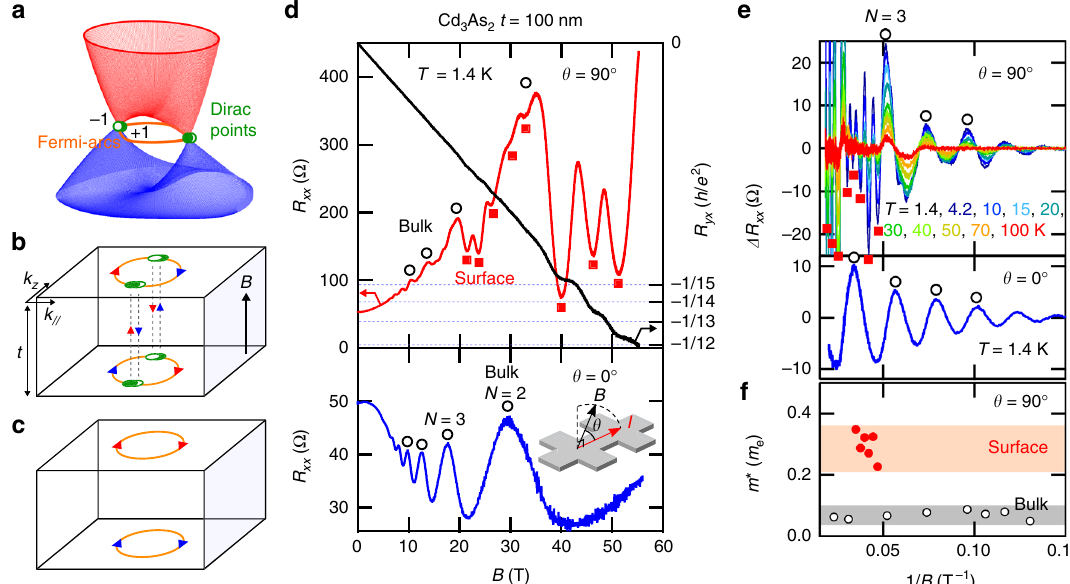
Fig. 1 Surface quantum transport in a Cd 3 As 2 thin fi lm. a Low-energy band dispersion of a Dirac semimetal (DSM). DSM consists of two copies of a Weyl semimetal superimposed with opposite chirality ±1. b , c Magnetic orbits mediated by the surface states in a DSM slab with thickness t . The two Fermi-arcs on the top and bottom surfaces are interconnected through the bulk chiral zero mode in b , while the two Fermi-arcs on the same surface deform into a closed Fermi pocket to form a conventional orbit localized at each surface in c . d Out-of-plane transverse (upper panel) and longitudinal (lower panel) magnetoresistances (MRs) of a 100 nm thick Cd 3 As 2 fi lm. The right axis of the upper panel shows Hall resistance R yx . θ indicates an angle between the fi eld B and current I . Filled squares denote the oscillation component observed only in the transverse MR, while open circles denote the 3D bulk oscillations observed in both the transverse and longitudinal MRs. Accompanied by sharp resistance drops in R xx in the higher fi eld region, R yx shows plateau-like structures, indicating the appearance of 2D quantum Hall states. e Temperature dependence of the oscillatory components in the transverse and longitudinal MRs and f extracted effective mass m * plotted as a function of 1/ B . The quantum oscillations at higher fi elds are characterized by larger F S and m * than the bulk one, which are ascribed to the surface